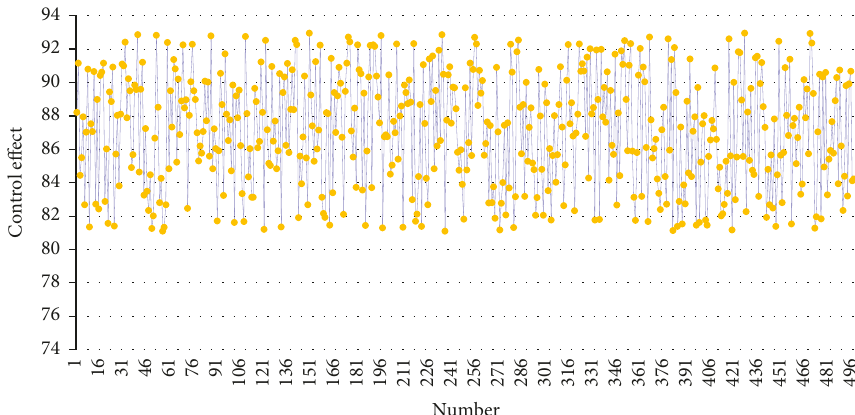
Figure 8: Verification of the effect of the electronic controller automation system based on artificial intelligence technology.